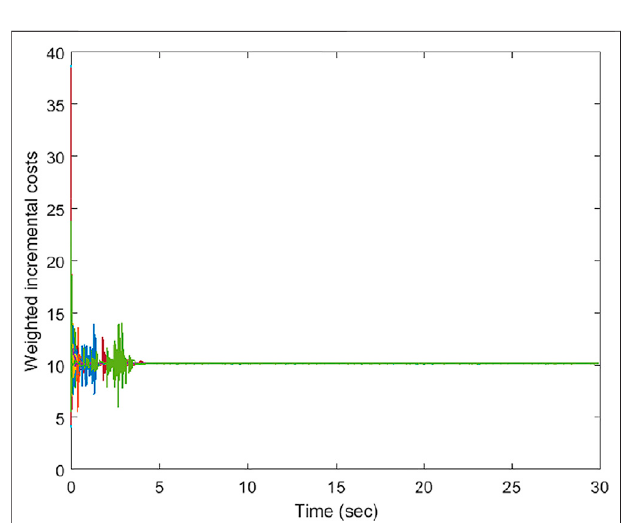
FIGURE 8 | Generation obtained under unity weights for IEEE-118 bus system.